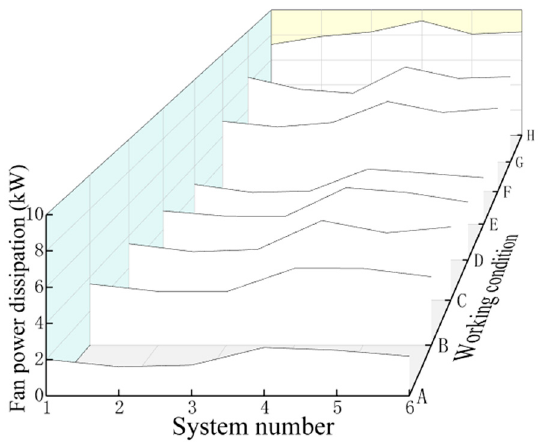
Figure 15. Under 15 °C total fan power consumption of each system under different working conditions.